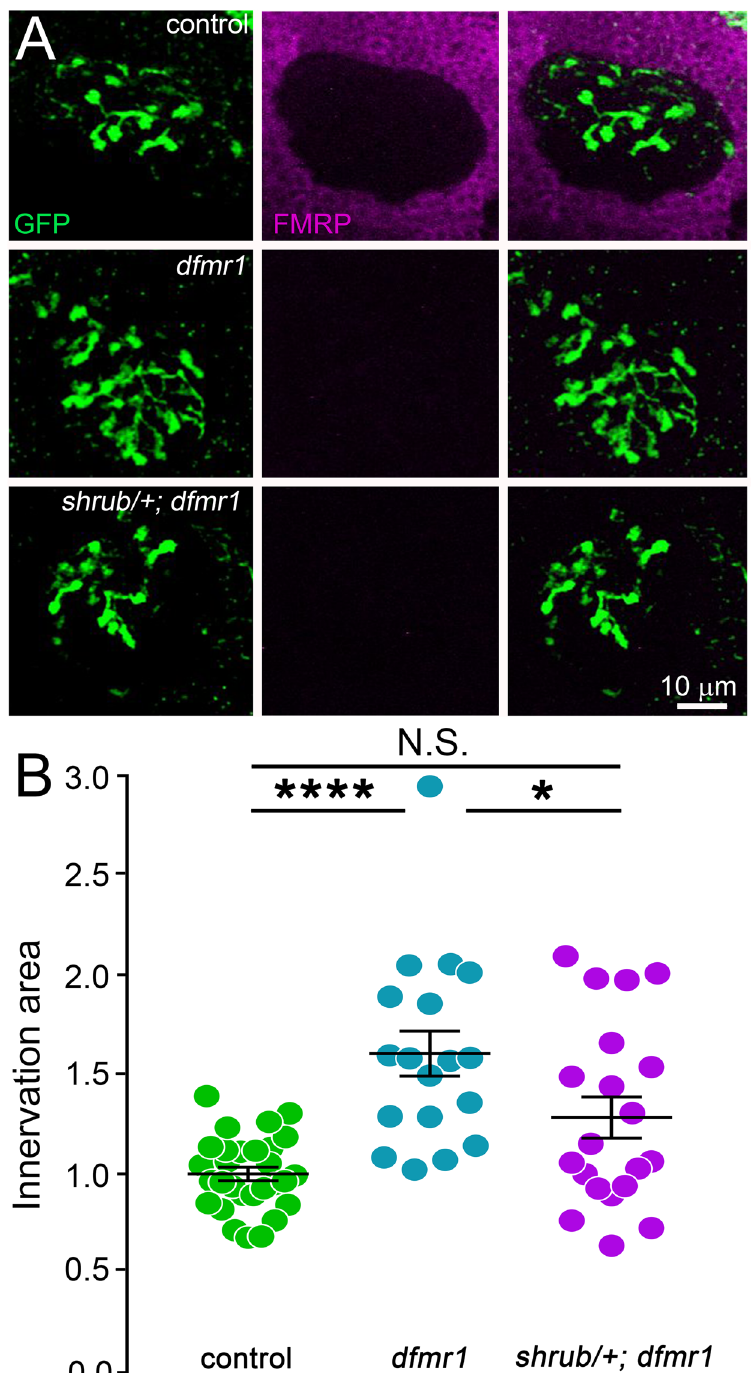
Figure 7. Shrub correction in dfmr1 null mutants restores PN innervation of MB calyx. ( A ) Representative confocal images of PN innervation of the MB calyx comparing transgenic control (UAS-mCD8::GFP/ + ; Nrv3-Gal4/ + ), dfmr1 null mutant (UAS-mCD8::GFP/ + ; Nrv3-Gal4, dfmr1 50M / dfmr1 50M ) and shrub 4 null heterozygote ( shrub 4 / + ) in the dfmr1 homozygous null background (UAS-mCD8::GFP/ shrub 4 ; Nrv3-Gal4, dfmr1 50M / dfmr1 50M ). PN (green) in the calyx, with anti-FMRP labeled (magenta). ( B ) Quantification dot plot of MB innervation area showing mean ± SEM in the above three genotypes. Statistics done with one way ANOVA with the Kruskal-Wallis test followed by a Dunn’s multiple comparison test post hoc indicated as N.S. P > 0.05, * P < 0.05 and **** P <